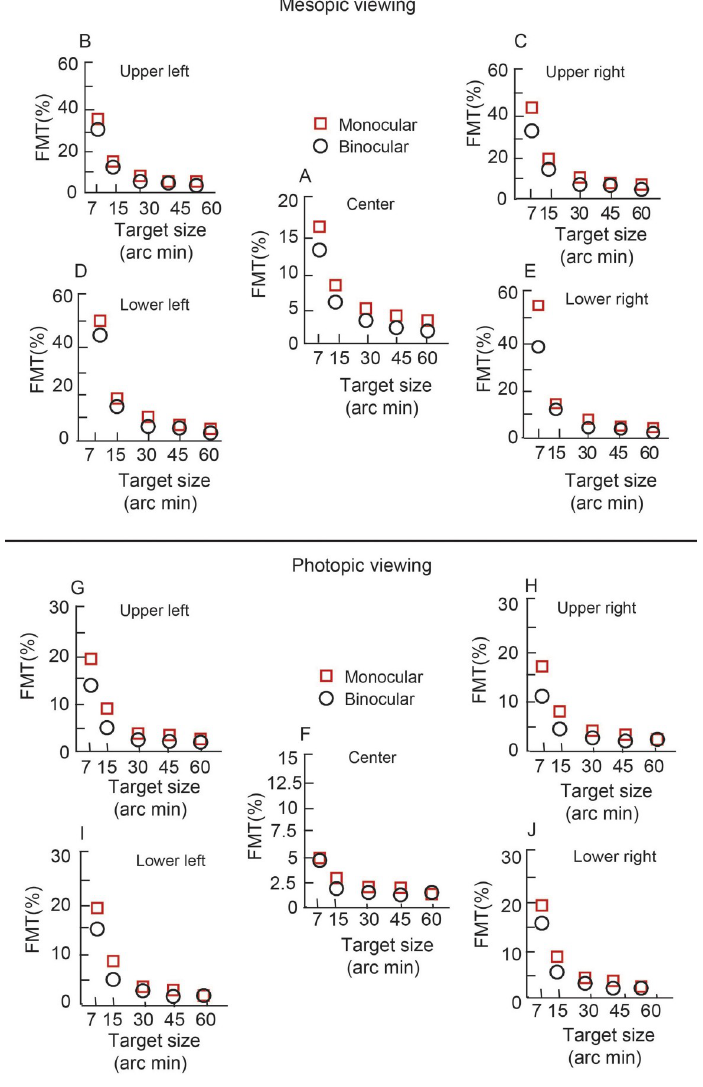
Fig 3. Representation of better of the two eyes’ monocular FMTs and binocular FMTs. Mesopic (top) and photopic viewing (bottom) conditions for an individual subject at the point of regard and in each of the four quadrants plotted. Each data point represents the average FMT of the two runs for that target location. Ordinates for panels b to e and g to j are different from panels a and f, respectively. Ordinates are also different between mesopic and photopic conditions. size to avoid artefacts in the results. In this process, a total of 5, 9, 10, 7 and 12 data points from both eyes put together were triaged for target sizes 7’, 15’, 30’, 45’ and 60’, respectively, in the mesopic condition and 10, 6, 6, 6 and 11 data points from both eyes put together were triaged for 7’, 15’, 30’, 45’ and 60’, respectively, in photopic condition. BSRs were calculated for each stimulus combination as the ratio of the monocular FMT for the best eye to the corresponding binocular threshold. Alternate methods for calculating the BSR such as averaging the two monocular outputs or normalizing the components of the binocular input to their respective monocular thresholds was not followed, for the former technique is known to overestimate BSRs and the latter technique is meaningful only in situations where the two monocular thresholds exhibit significant interocular differences [2].